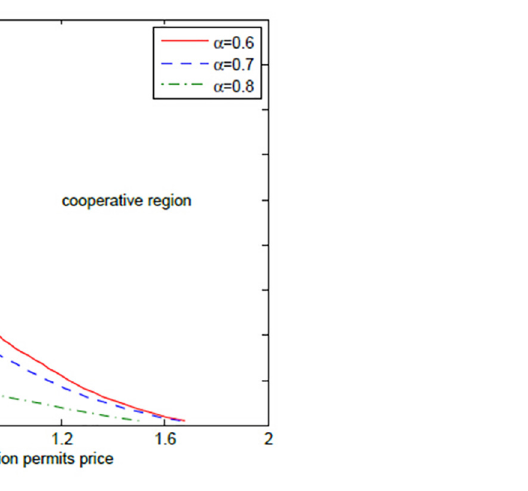
Fig 4. The effects of α on the optimal decision